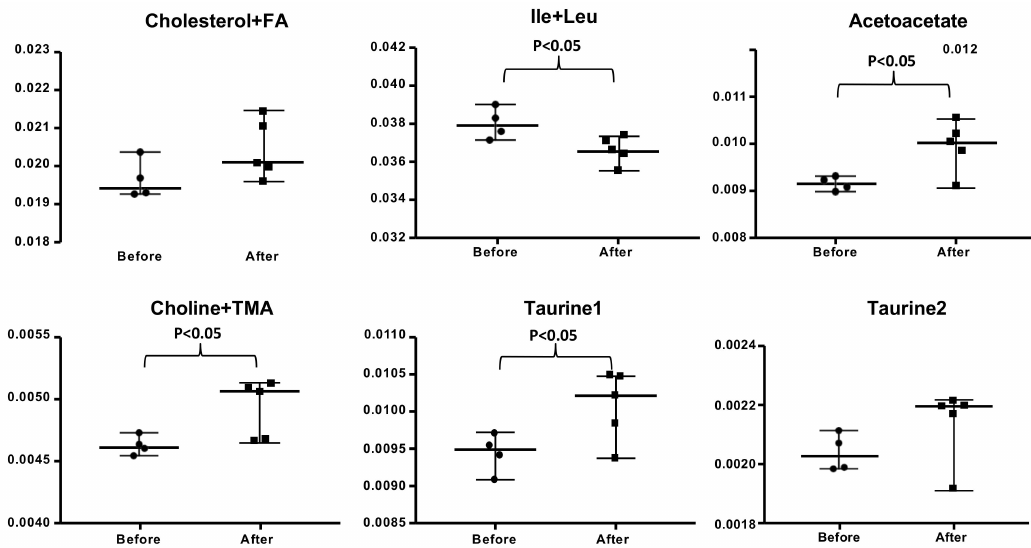
Figure 3. Metabolic relative content (mean relative spectral intensity) for spectral regions enriched in fatty acids (FA) and cholesterol, isoleucine and leucine, acetoacetate, choline and trimethylamine, and taurine. Data are expressed as median and range with 95% CI. The statistical significance is expressed as p <